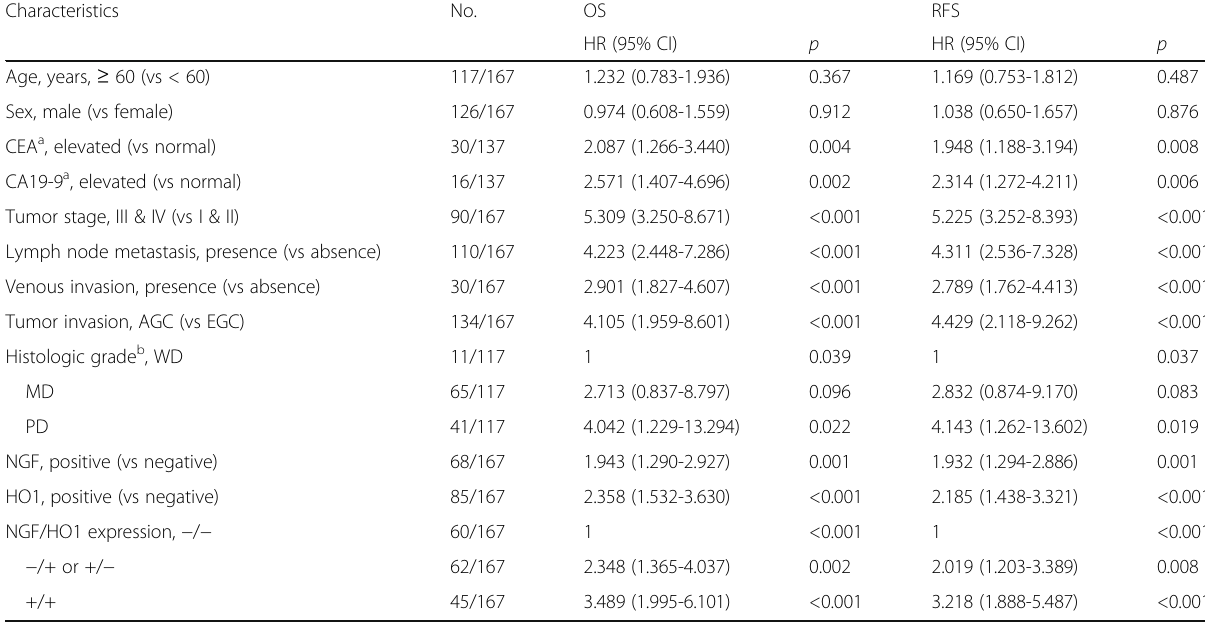
Table 2 Univariate Cox proportional hazards regression analysis for the survival of gastric carcinoma patients